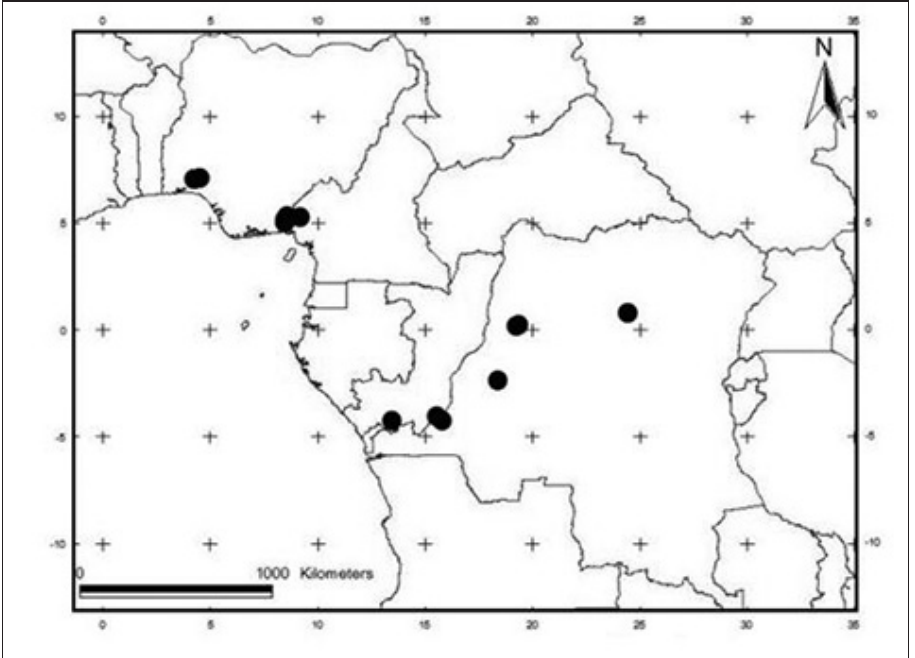
Figure 2. Distribution map of Craterispermum capitatum